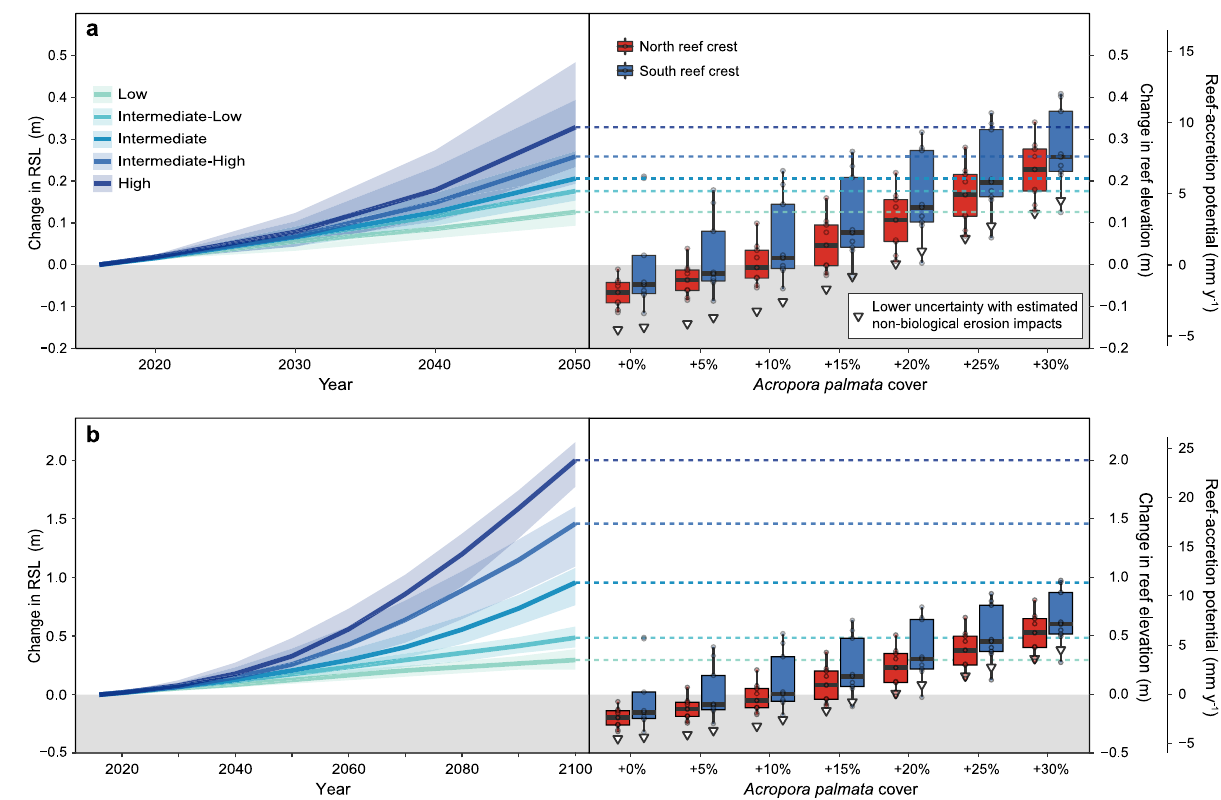
Fig. 3 | Carbonate-budget models showing how increases in Acropora palmata through restoration could improve the ability of reef-crest habitats at Buck Island Reef National Monument (BIRNM) to keep pace with future sea-level rise. These results indicate thatif A.palmata cover couldbe increasedby ~30% (to total mean cover of 36 and 45% for the northern and southern reef crest, respec- tively), the reef could keep pace with Low to Intermediate-Low projections of relative sea-level (RSL) rise. Median projections (solid to dashed lines; shading representstwo-standard-deviation con fi dence intervals)offuturerelative sea-level rise for St. Croix (relative to 2016; NOAA Tide Station # 9751401; ref. 31) to 2050 a and 2100 b are based on the fi ve (Low to High) sea-level-rise scenarios evaluated in Sweet et al. 31 . The sea-level-rise projections (left) are compared with carbonate-